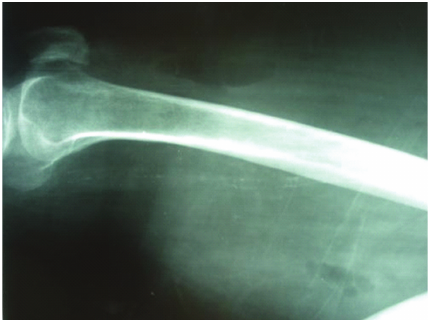
Figure 2: The surgical wound at the hip region. Pus, fecal material, and air bubbles can be observed coming out of the great sciatic foramen after the patient was asked to cough.